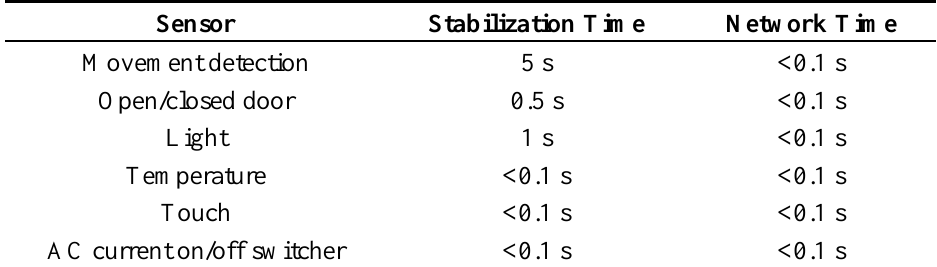
Table 1. Sensor platform response times (the values were rounded to the second) after 30